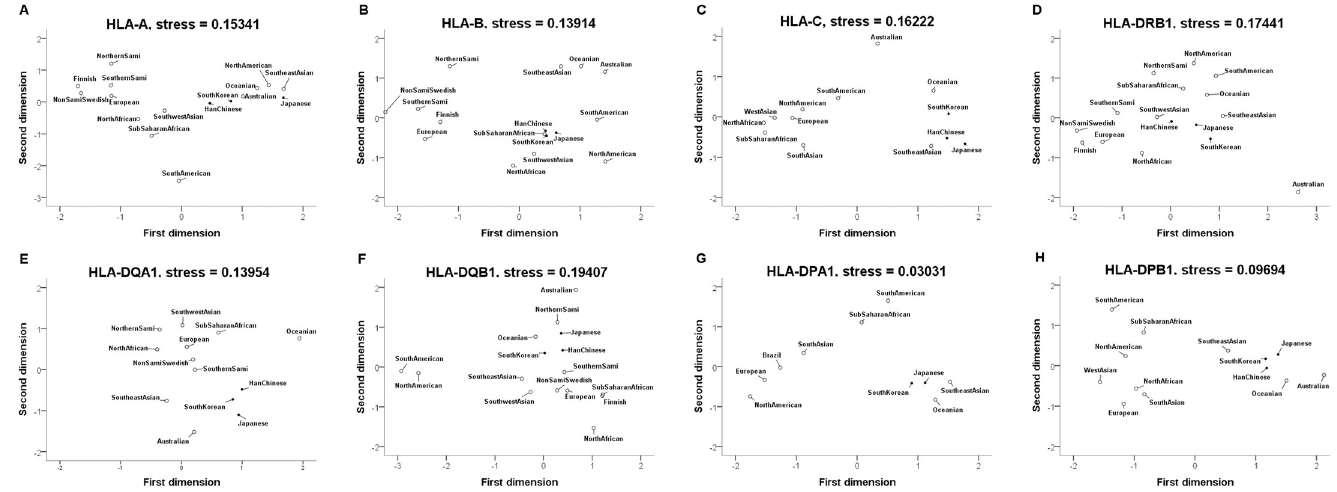
Fig 1. Euclidian distances by two dimensional MDS plots for allele frequencies of 8 HLA loci. (A) HLA-A, (B) HLA-B, (C) HLA-C, (D) HLA-DRB1, (E) HLA-DQA1, (F) HLA-DQB1, (G) HLA-DPA1, (H) HLA-DPB1.